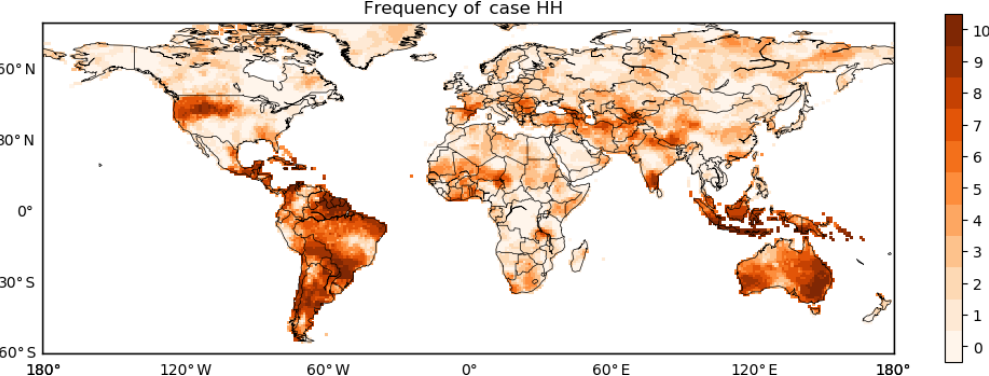
Figure 4. The spatial distribution of the frequency of case HH across the globe for the 10 sets of GCM forecasts of the total precipitation in JJA.